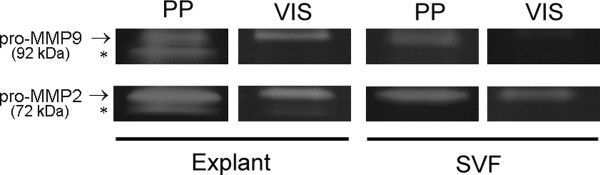
MMP2 and MMP9 enzymatic activities in supernatants of whole adipose tissue and SVF fraction from VIS and PP depots. Representative bands corresponding to specific MMP2 and MMP9 are shown. Asterisks indicate active forms of MMP2 and MMP9 while arrows indicate the respective proforms. SVF, stromal-vascular fraction; PP, periprostatic; VIS, visceral; MMP, matrix metalloproteinase.